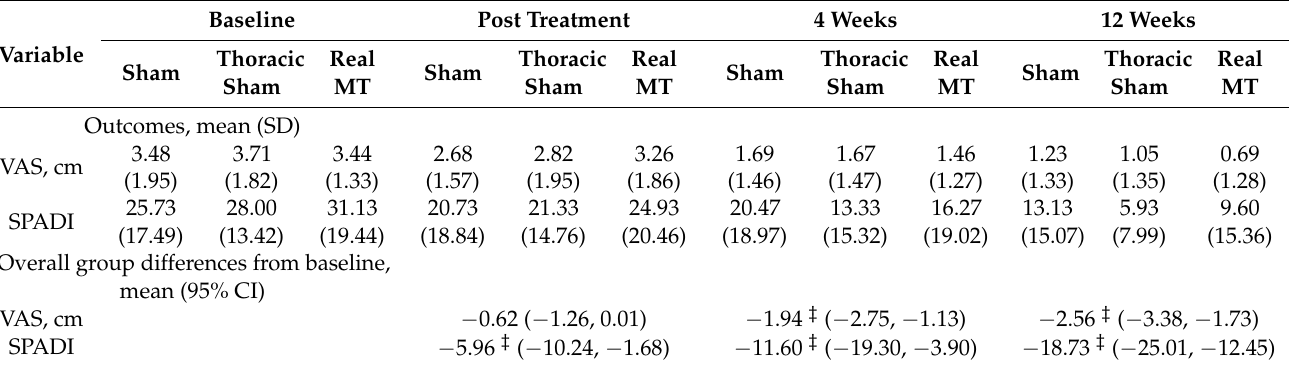
Table 2. Pain and disability differences from the baseline.